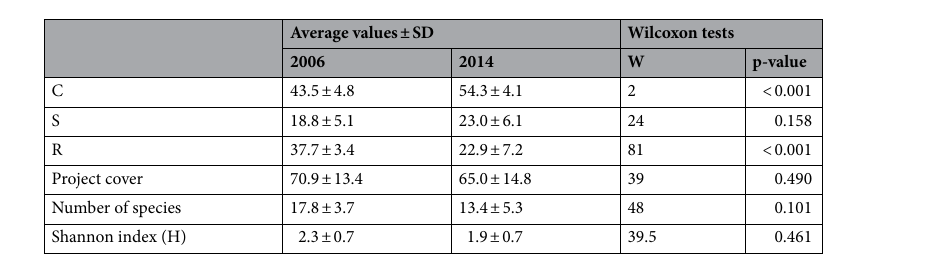
Table 4. Average competition–stress–ruderality (CSR) scores and biodiversity indices for experimental plots. SD denotes standard deviation; C, S, and R are scores on the competitiveness, stress tolerance, and ruderality scales, respectively; Sample size n =